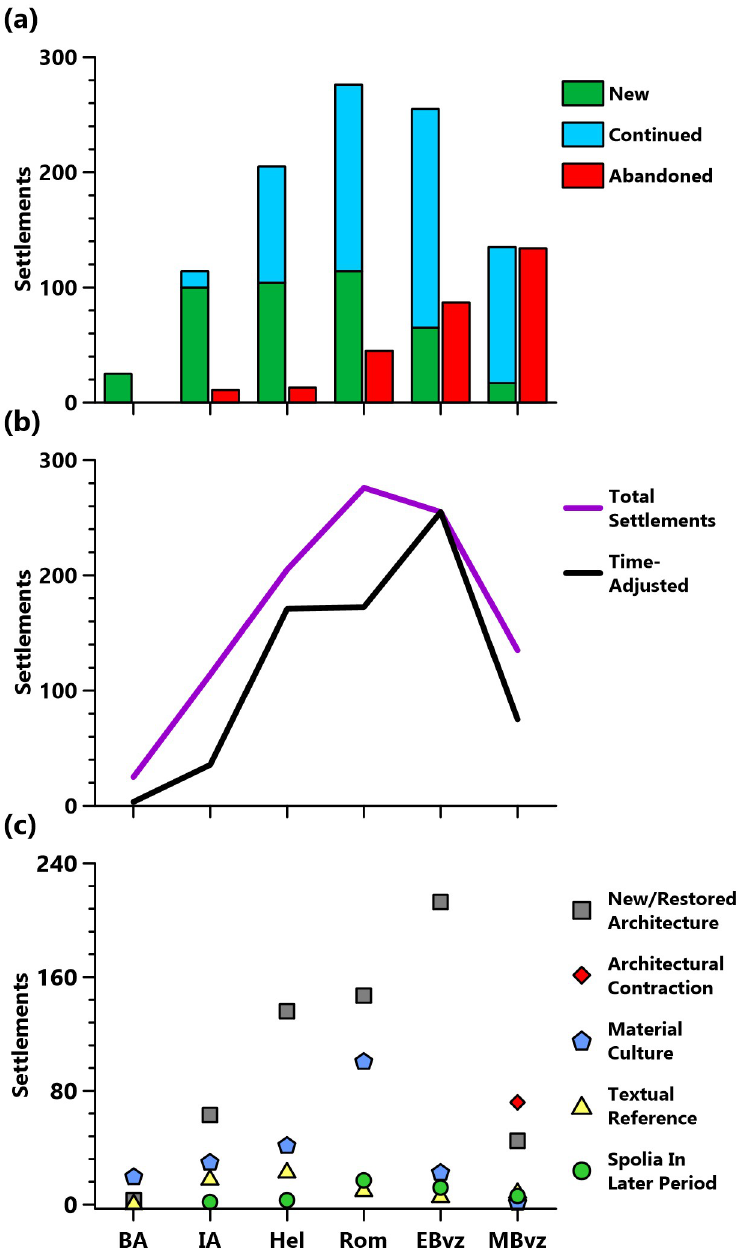
Fig 2. Presentation of the TIB-derived dataset. ( a ) Total settlement data, ( b ) time-adjusted data ( c ) settlement numbers by evidence